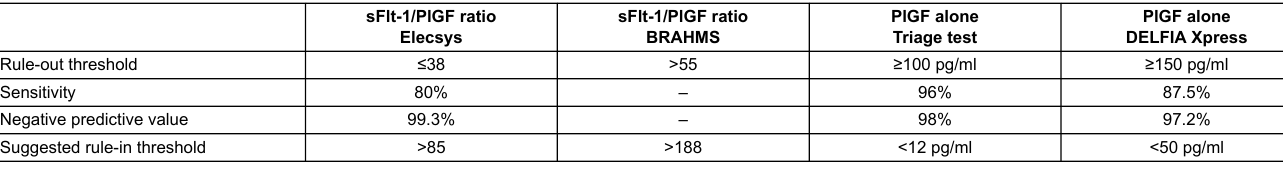
Table 3: Available PlGF tests on the Swiss market; rule-out thresholds and